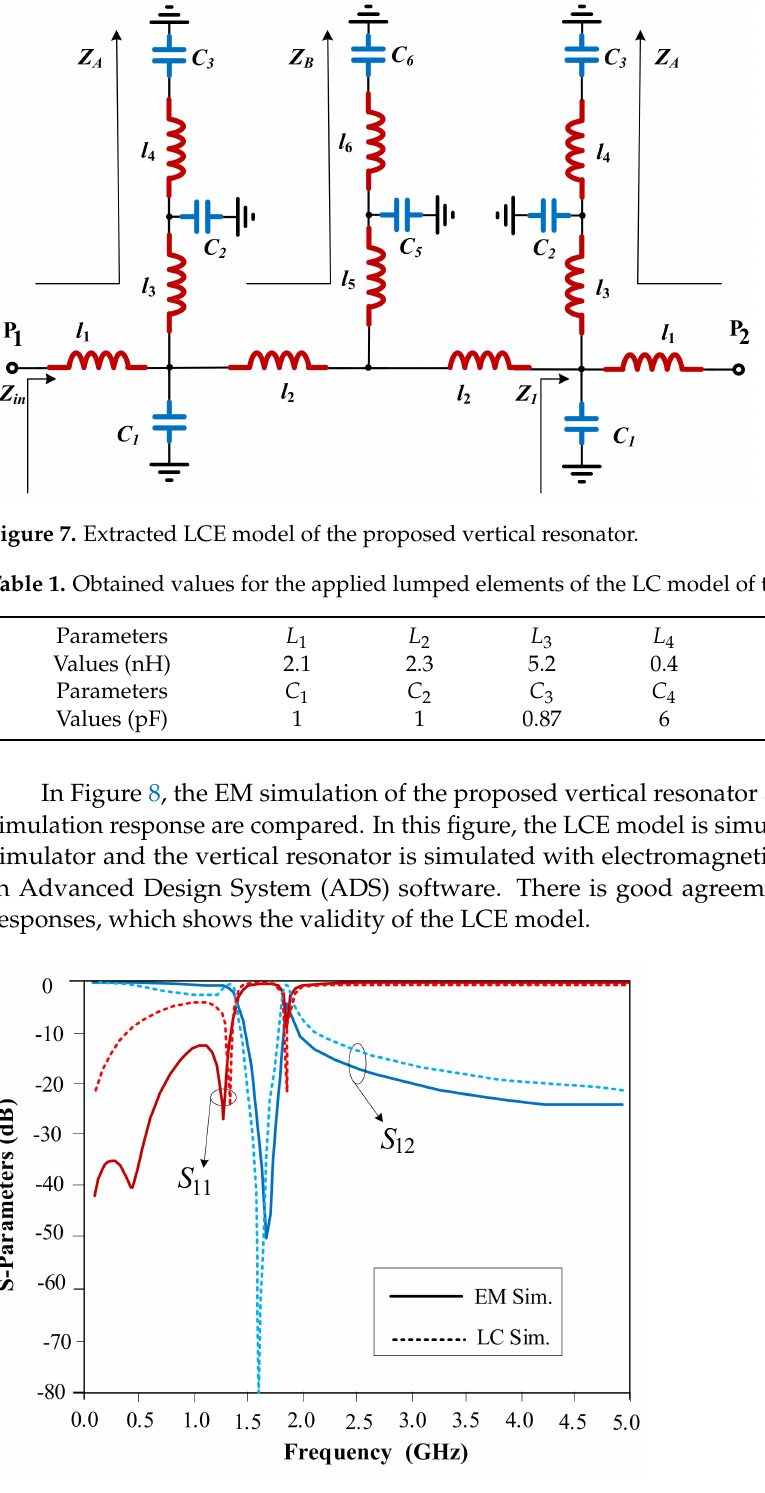
Figure 8. EM simulation of the proposed vertical resonator and its LCE model